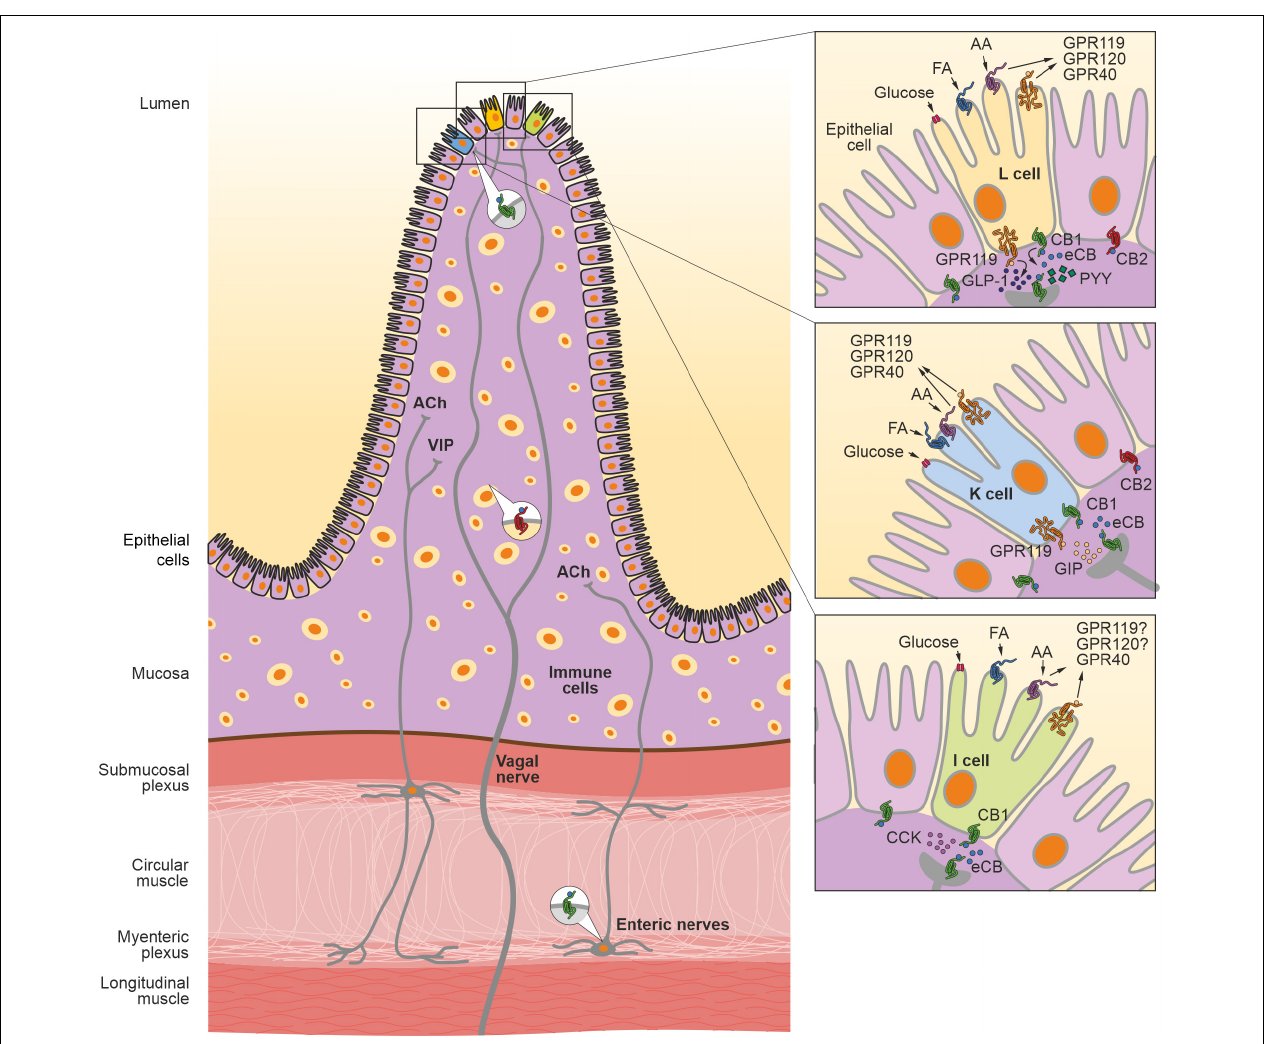
FIGURE 1 | The endocannabinoid system in the gastrointestinal tract. The crosstalk between the intestinal eCB system and microbiota regulates many GI functions, such as gut permeability, motility, hormonal secretion, nutrient absorption and immune response. CB1R is expressed in different cells in the gut, including epithelial cells (colored in violet) and different types of enteroendocrine cells (colored in yellow, L cell; blue, K cell, and green, I cell, respectively) in the mucosa layer. In the myenteric and submucosa plexus, CB1R is present in the enteric nervous system, in particular, in the cell bodies of cholinergic neurons containing the neurotransmitter acetylcholine (ACh). Furthermore, CB1R is expressed in the afferent vagal neurons. CB2R is expressed in immune cells as well as in the epithelial cells in the mucosa. AA, arachidonic acid; CCK, cholecystokinin; FA, fatty acids; GIP, gastric inhibitory peptide; GLP-1, glucose-like peptide 1; GPR119, G protein-coupled receptor 119; GPR120, G protein-coupled receptor 120; GPR40, G protein-coupled receptor 40; PYY, peptide